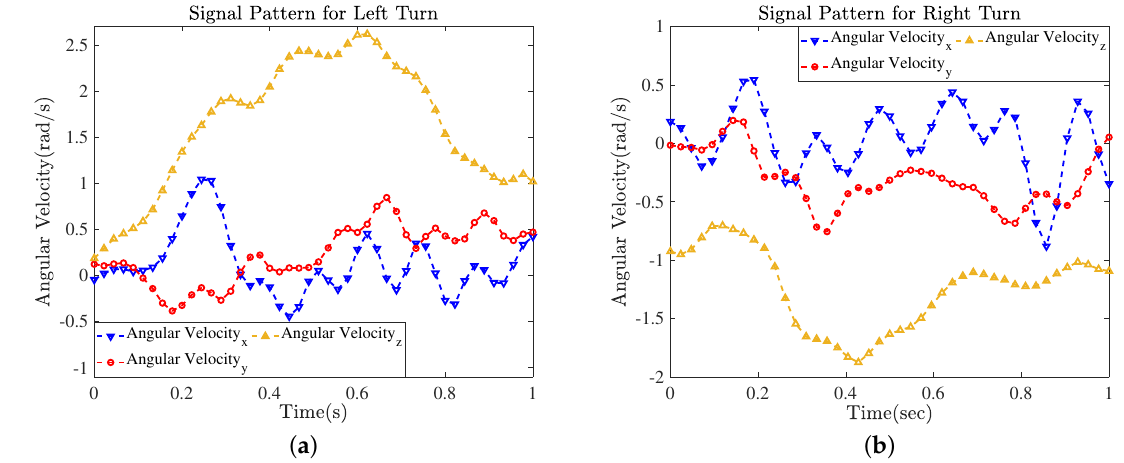
Figure 10. Gyroscope signal patterns for ( a ) left and ( b ) right